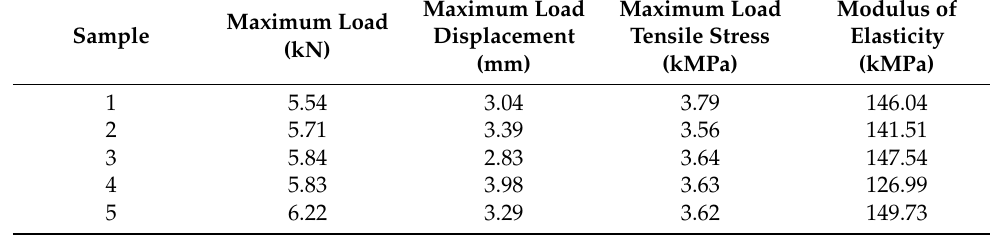
Table 2. Parameters of mechanical properties of composites with different contents of graphene.